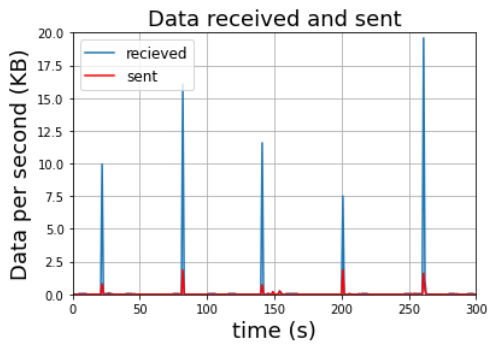
Figure 3. CPU & RAM usage for ChronoEOS 2.0.